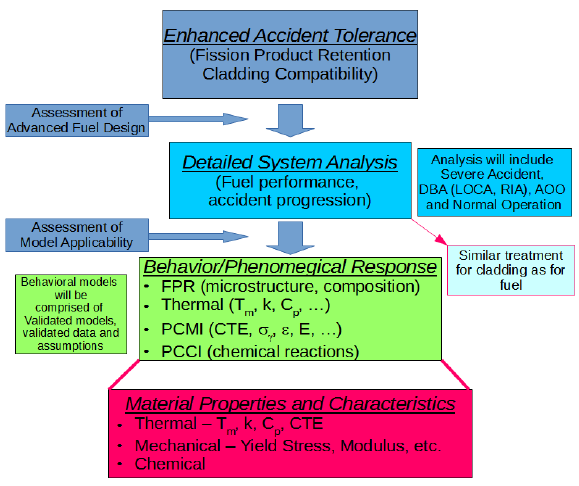
Figure 4. A diagram that describes an approach to assessing enhanced accident attributes of a proposed fuel